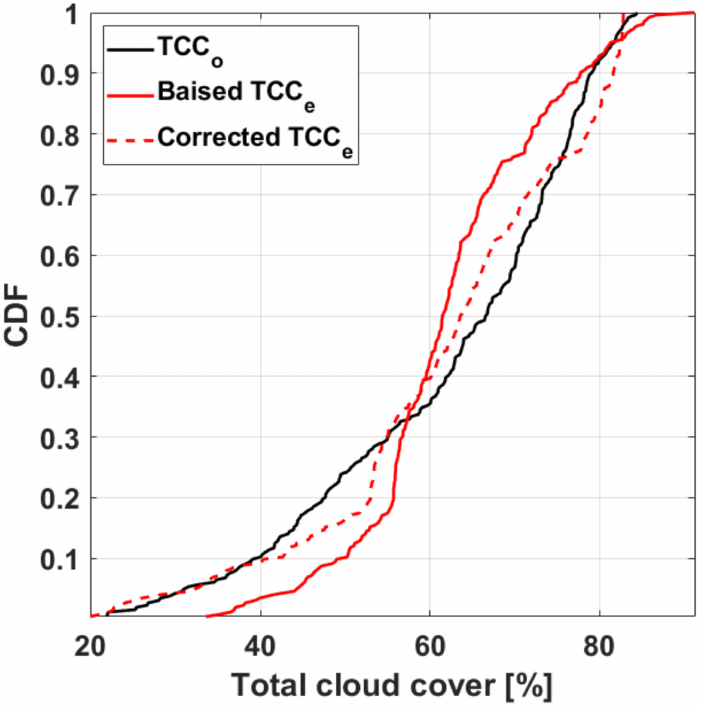
Figure 2. Improved estimation by CDF matching. The black line is the CDF of station-observed total cloud cover, the red line and red dashed line are the CDFs of estimated (biased) and corrected total cloud cover,